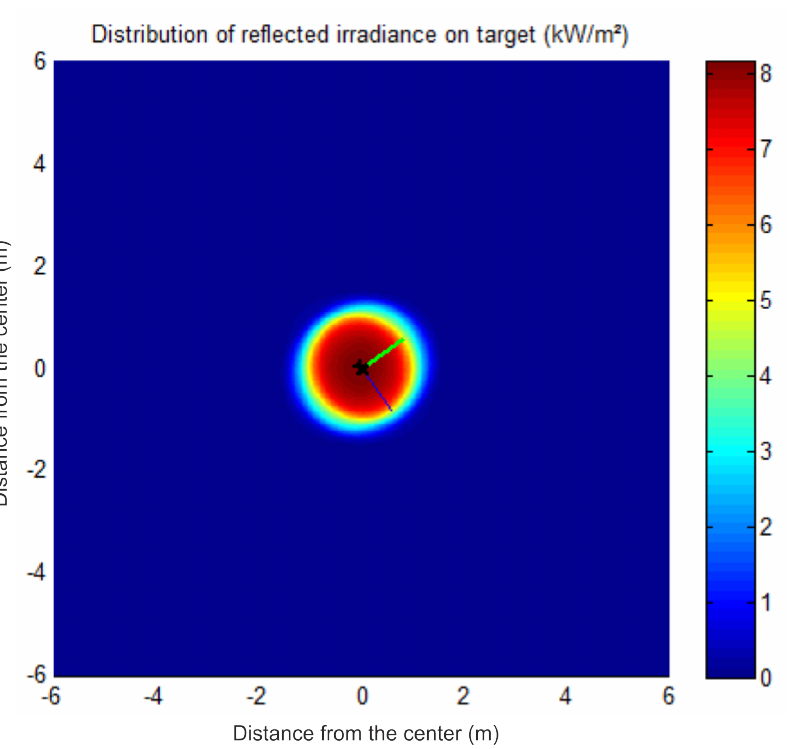
Figure 12. Flux distribution on the target (10 March 2017 at 11:07 UTC).